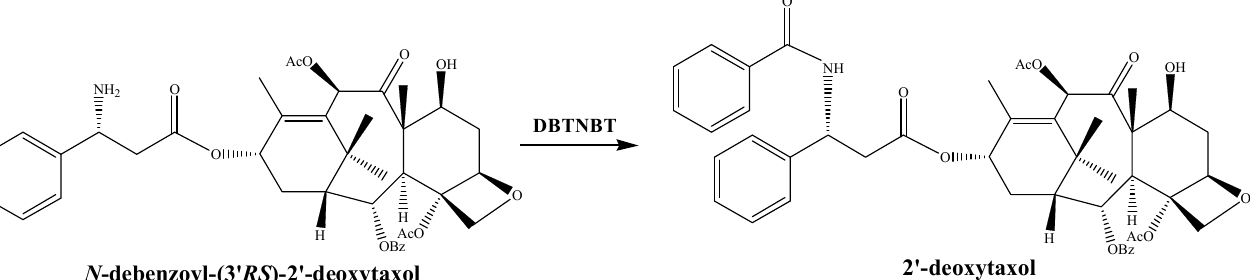
Figure 4. The enzyme DBTNBT catalyzes the surrogate substrate N -debenzoyl-(3 ′ RS )-2 ′ -deoxytaxol with benzoyl-CoA to form 2 ′ -deoxytaxol.